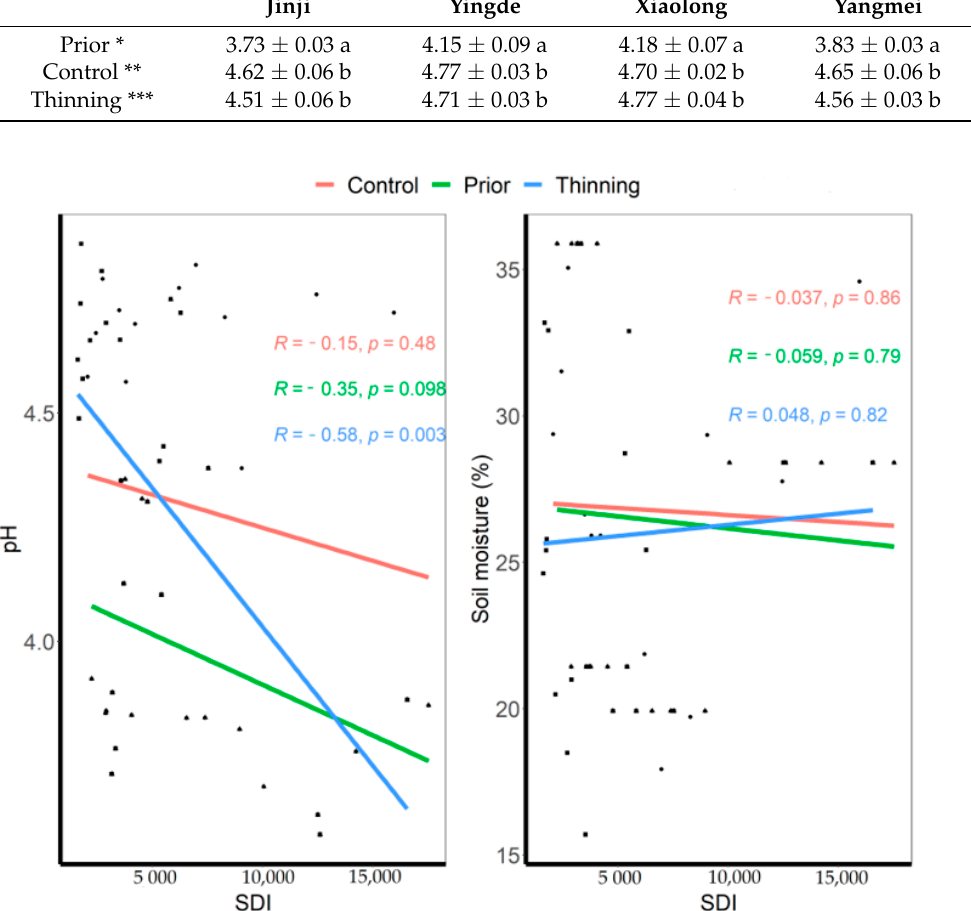
Figure 3. The relationship between SDI and soil pH (left) and soil moisture (right) of different treatments.